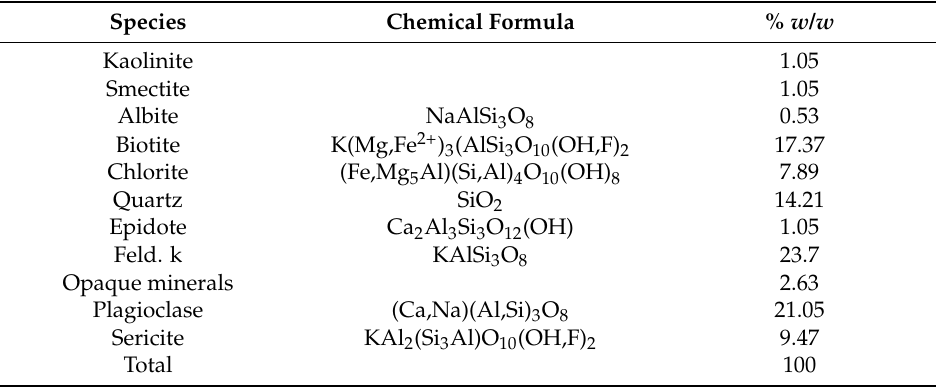
Table 1. Composition of the gangue minerals.